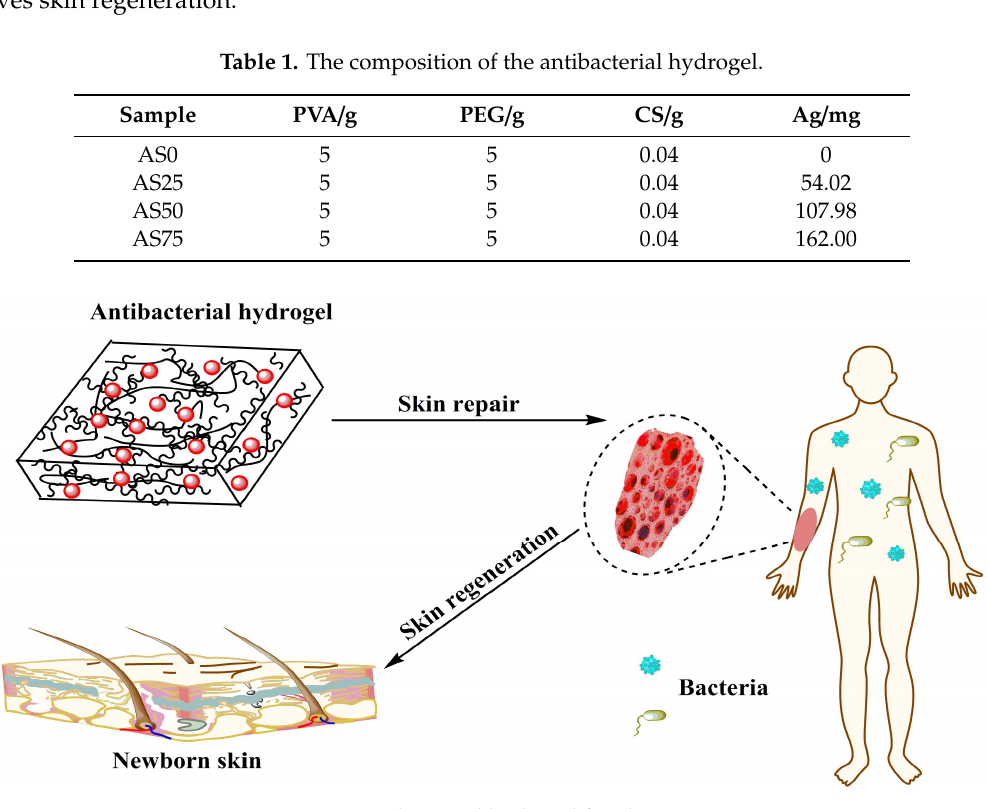
Figure 1. Antibacterial hydrogel for skin repair. Table 1. The composition of the antibacterial hydrogel.